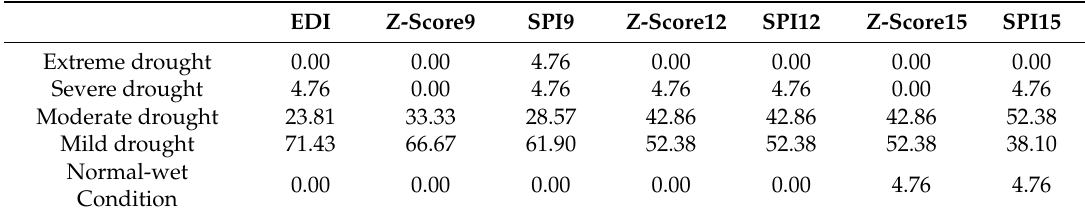
Table 5. Drought frequency (%) of detected by DIs in Keshan during September 1999 to May 2001. EDI